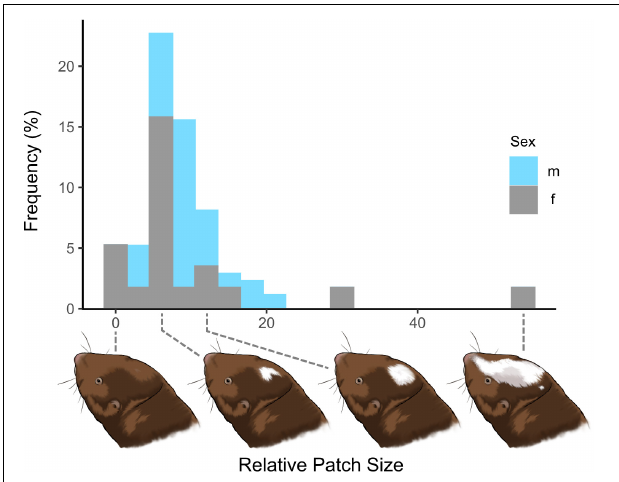
FIGURE 2 | Frequencies of individual relative patch sizes ( x -axis) in Ansell’s mole-rats. The patch size distribution in females is more variable than the one in males. Drawings of the heads by Kai R.